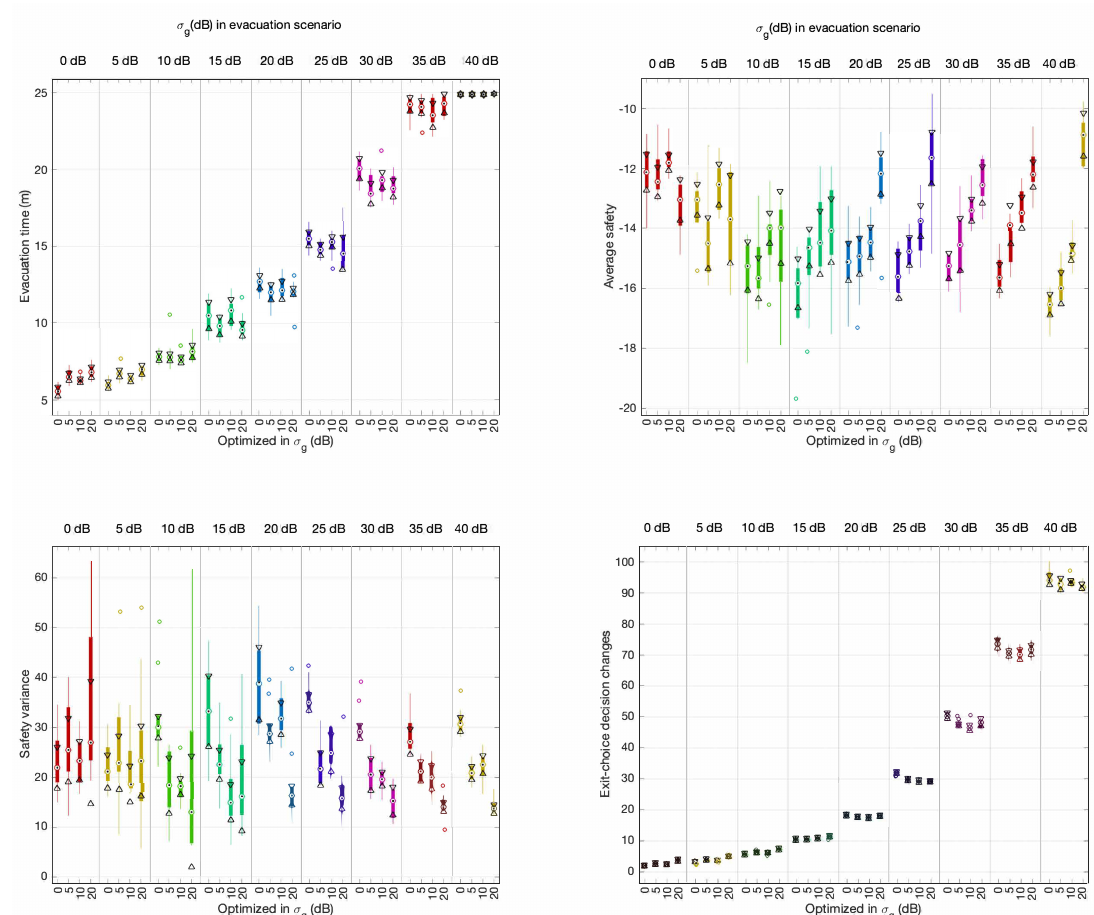
Figure 12. Median box-plots of the performance measurements of the optimal configurations of CellEVAC for σ g = 0,5,10,20 dB, in evacuation scenarios without external pedestrian flows and with positioning uncertainty levels from 0 dB to 40 dB in steps of 5 dB. Bottom horizontal axes categorize the optimal configuration of parameters used (0, 5, 10, or 20 dB) to configure CellEVAC. Upper horizontal axes categorize the σ g value that models the positioning system in the evacuation scenario. For instance, a value of 25 dB in the axis “ σ g (dB) in evacuation scenario” and 15 dB in “optimized in σ g (dB)” expresses that CellEVAC has been configured to use the optimal configuration found with 15 dB, and that it is tested in an evacuation scenario with σ g = 25 dB. The triangles in the box-plots display the variability of the median between samples. If the notches of two measurements do not overlap, they have different medians at the 5% significance